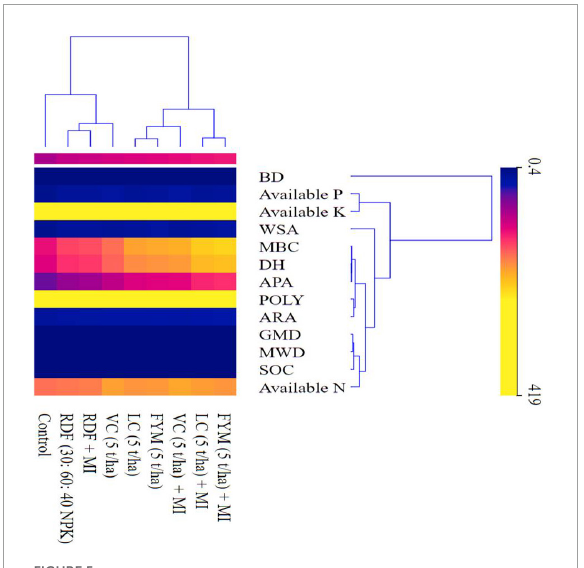
FIGURE5 The heat map depicting the clustering of soil physical, chemical, and biological properties. MWD, mean weight diameter; GMD, geometric mean diameter; BD, bulk density; WSA, water stable aggregates; OC, organic carbon; N, nitrogen; P, phosphorus; K, potassium; DH, dehydrogenase; APA, alkaline phosphatase activity; MBC, microbial biomass carbon; ARA, acetylene reduction activity; POLY, total